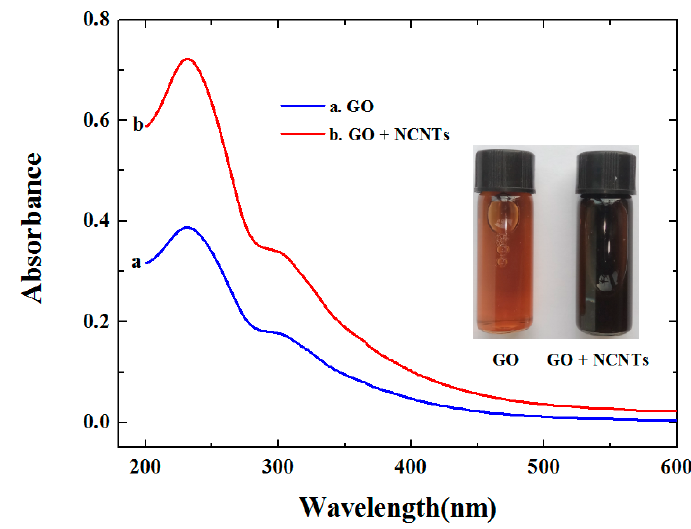
Figure 1. UV-visible absorption spectra of graphene-oxide (GO) ( a ) and graphene oxide-nitrogen doped carbon nanotubes (GO-NCNTs) ( b ); the inset shows the objects of GO ( a ) and GO-NCNTs ( b ).